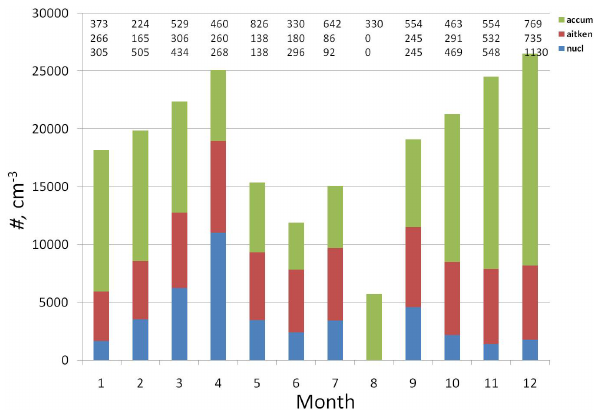
Fig. 6. Annual variation of total and modal particle number concen- trations during the measurement period. Nucleation mode < 25 nm, Aitken mode 25nm < d p < 75nm, accumulation mode > 75nm. Number of hours measured during each month for each mode is also